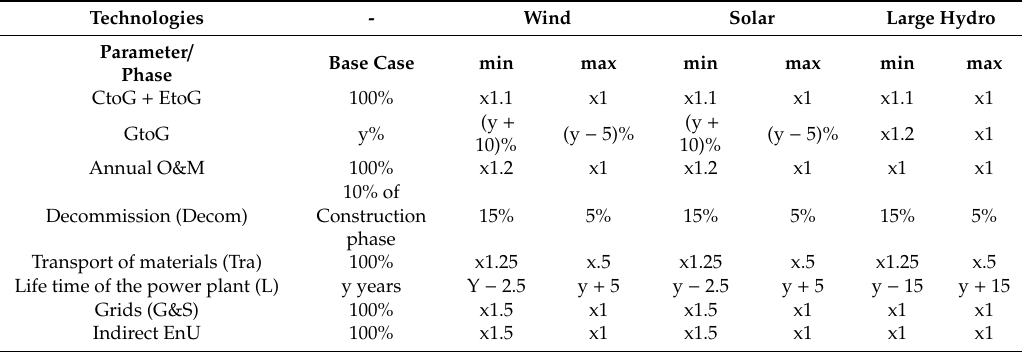
Table A1. Sensitivity analysis. Minimum and maximum ranges (taking into consideration its e ff ect on the EROI of each technology), around the base case factor evaluated in the main text, for each technology. See text for